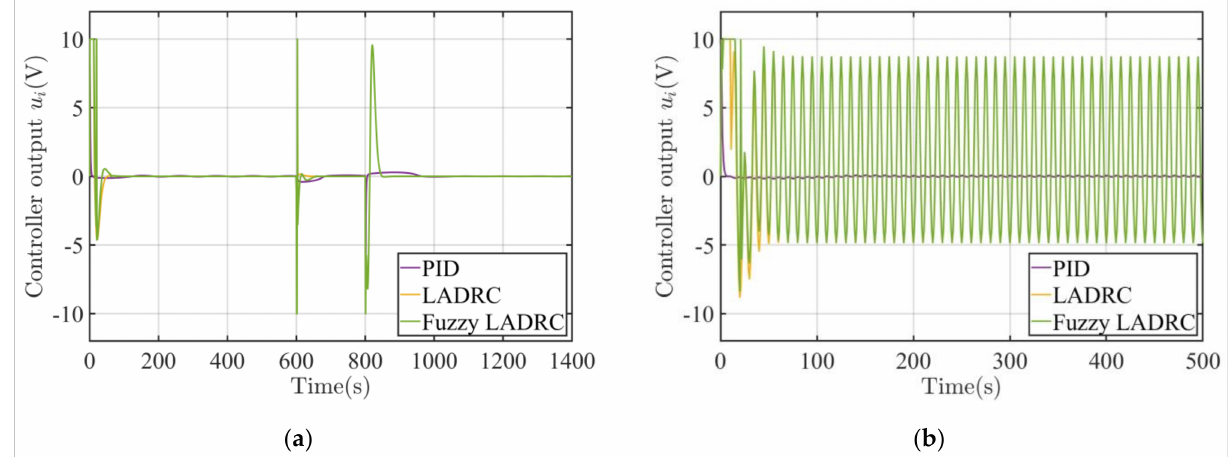
Figure 10. Controller outputs of the AUV system with two types of disturbance force. ( a ) Step disturbance. ( b ) Sine